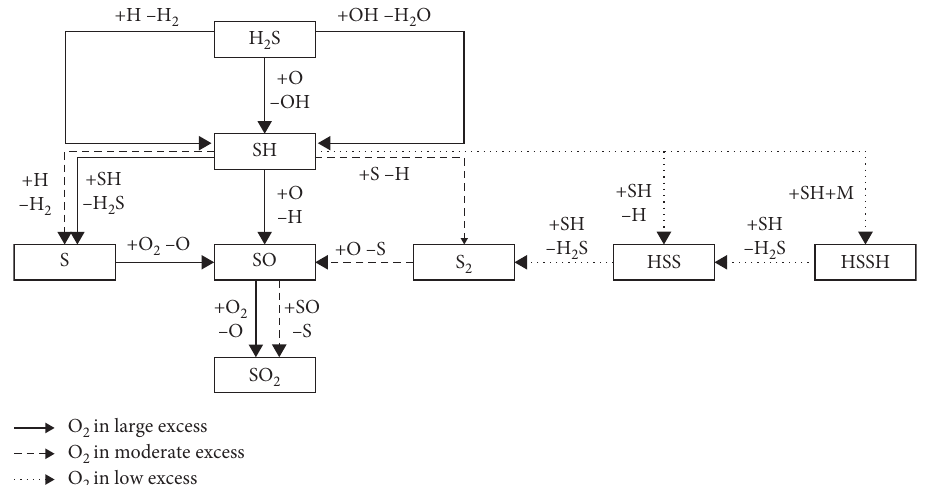
2 S oxidation showing main consumption pathways.